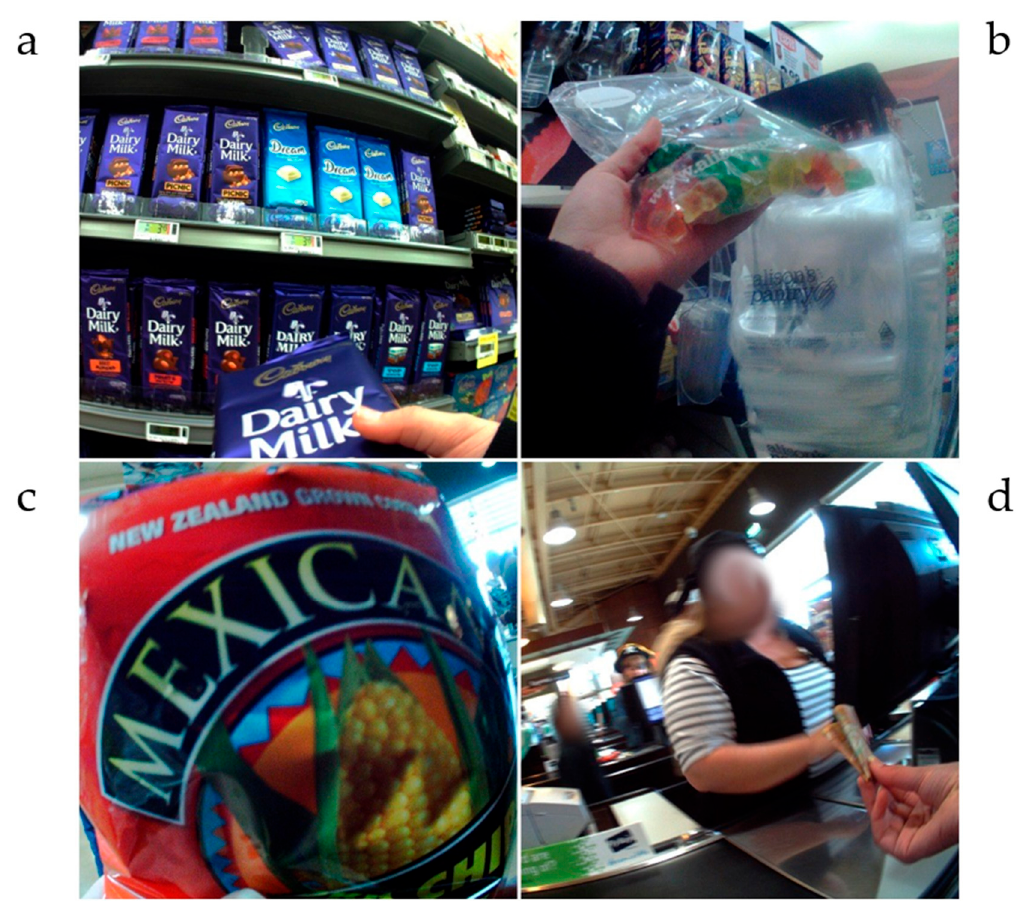
Figure 3. Food purchases in a supermarket. ( a ) chocolate; ( b ) confectionary from self-service pick and mix; ( c ) corn chips; ( d ) image of participant purchasing food at checkout.